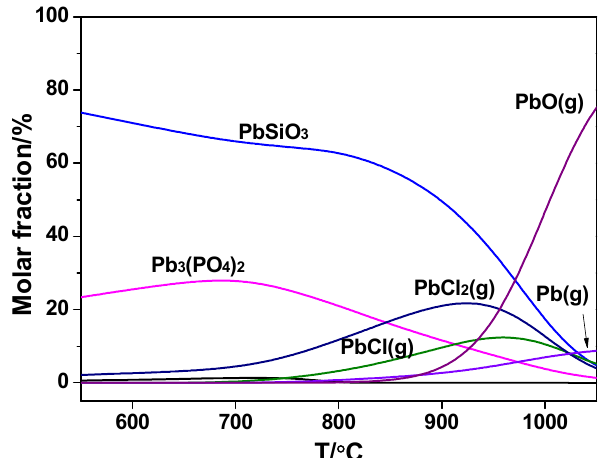
Figure 7. Effect of temperature on the distribution of Pb species in sludge combustion in thermodynamics.